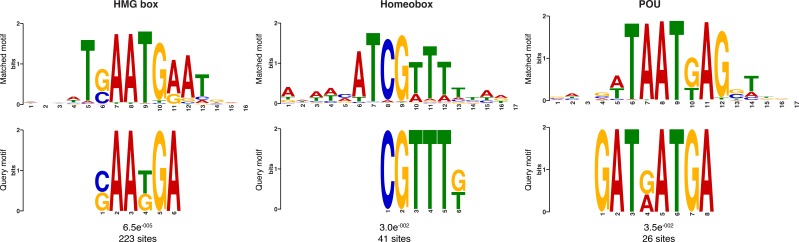
Additional sequence logos of the DNA motifs determined by MEME-ChIP analysis to be significantly enriched in the adult predicted activated enhancer-like sequences.The E-value (log likelihood ratio of each motif) and the number of sites contributing to the construction of the motif are shown, respectively. The matched motif is shown on the top and the query motif is shown on the bottom.